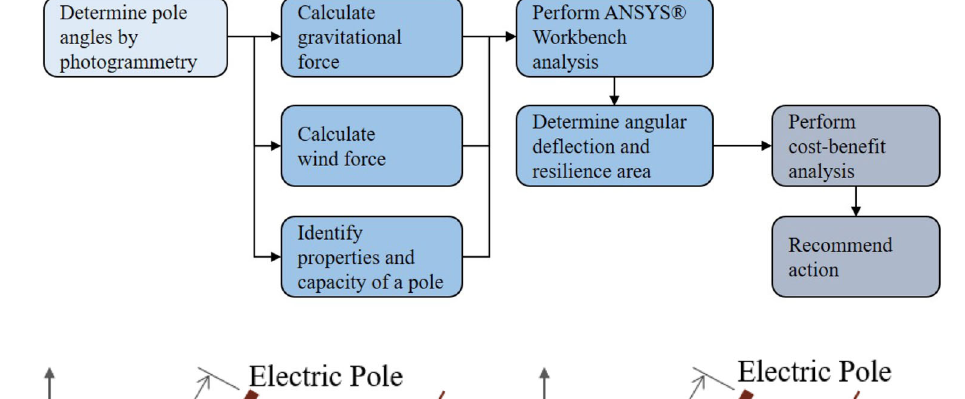
Fig. 2 Elements that determine pole capacity: a the wind load on a pole and b the gravitational load on a pole